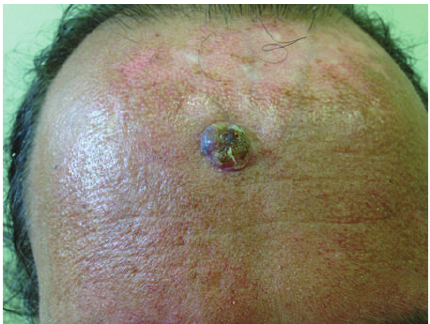
Figure 1: Basal cell carcinoma in